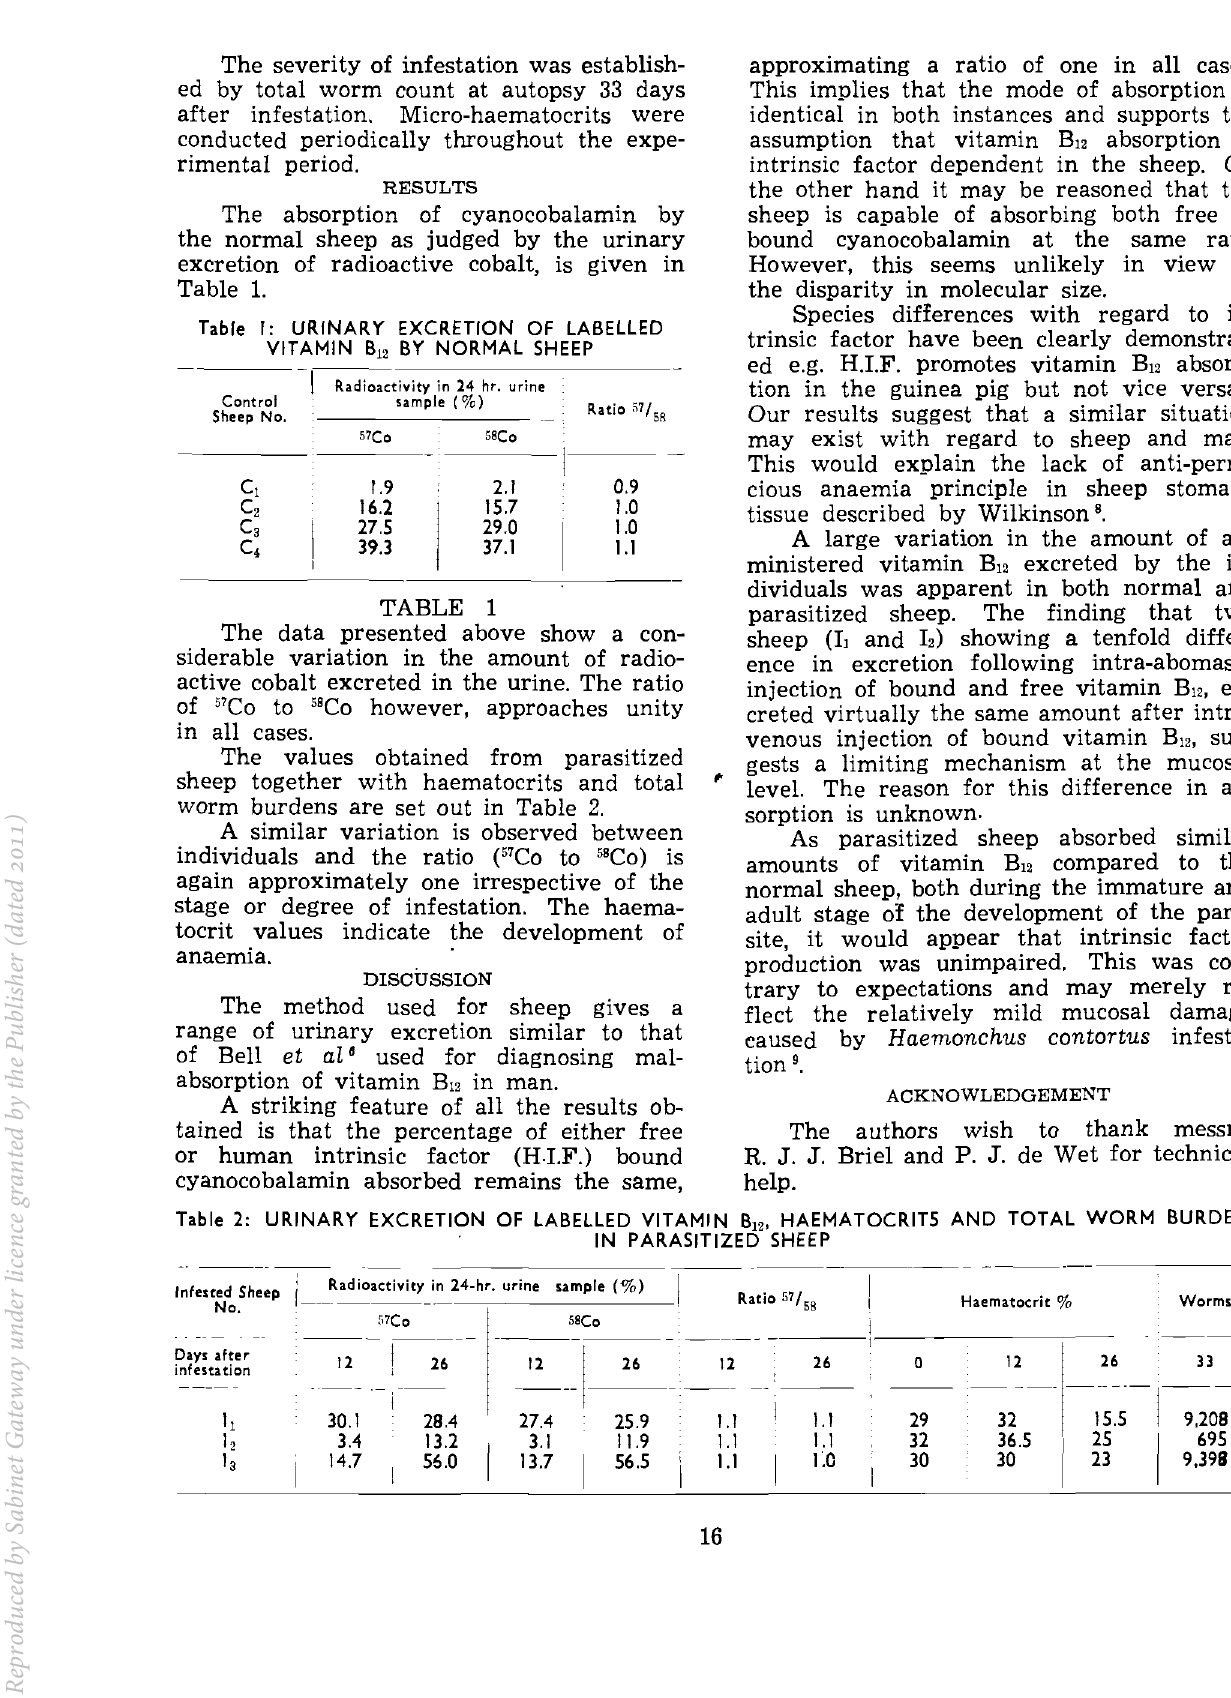
Table I: URINARY EXCRETION OF LABELLED VITAMIN B12 BY NORMAL SHEEP Radioactivity in 24 hr. urine Control